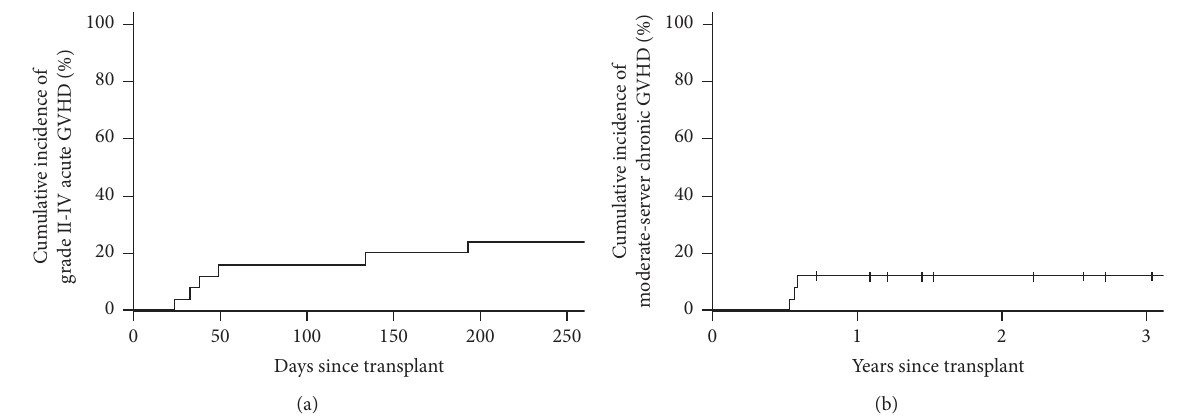
Figure 1: Cumulative incidence of (a) acute GVHD, and (b) chronic GVHD.